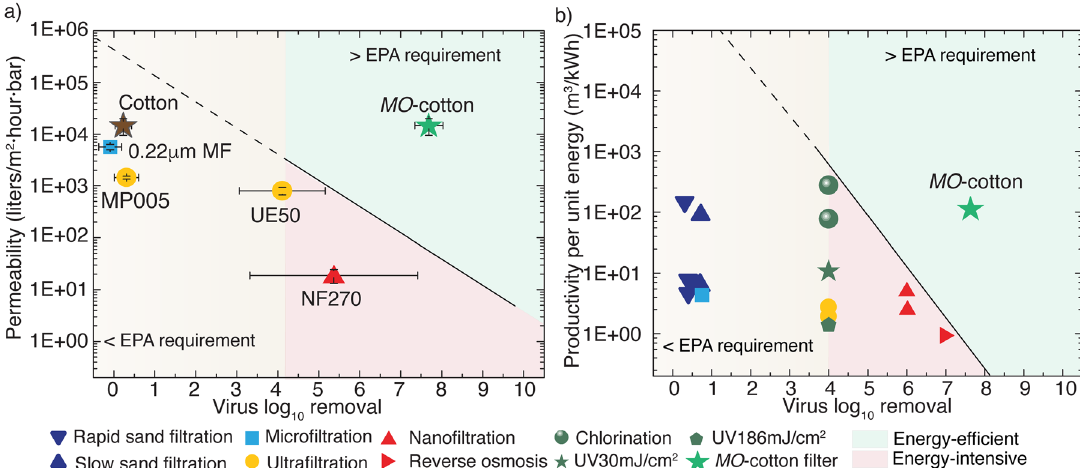
Fig. 7 MO- cotton fi lters show potential for an energy-ef fi cient solution for virus contamination removal compared to commercially available membrane fi lters. a The MS2 log removal ef fi ciency of various membrane fi lters tested in this work was compared to that of uncoated and coated cotton fi lters proposed in this study to show the advantage of MO functionalization. The experimental permeability and MS2 removal ef fi ciency values determined for the tested commercial membranes and MO -cotton fi lters are available in Supplementary Table 7. b Preliminary assessment of energy requirement for a theoretical point-of-use MO- cotton fi lter shows the energy required is much lower compared to membrane fi ltration and UV irradiation. The energy requirement for MO - fi lters is on par with conventional media fi ltration and chlorine disinfection. The energy requirement of various techniques shown in this fi gure is based on available literature and a detailed summary of the literature survey and energy requirement values used can be found in Supplementary Note 2 and Supplementary Table 5. All the error bars shown in the fi gure represent the standard deviation calculated from three independent